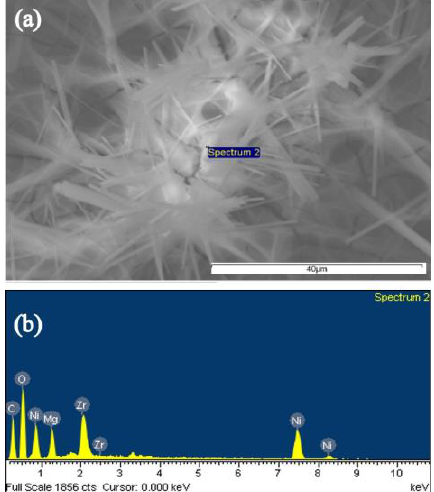
Figure 3. EDS analysis of MZN NR-based thin film ( a ) testing location and ( b ) chemical composition. Table 1. Atomic percentage of MZN NR-based thin films.